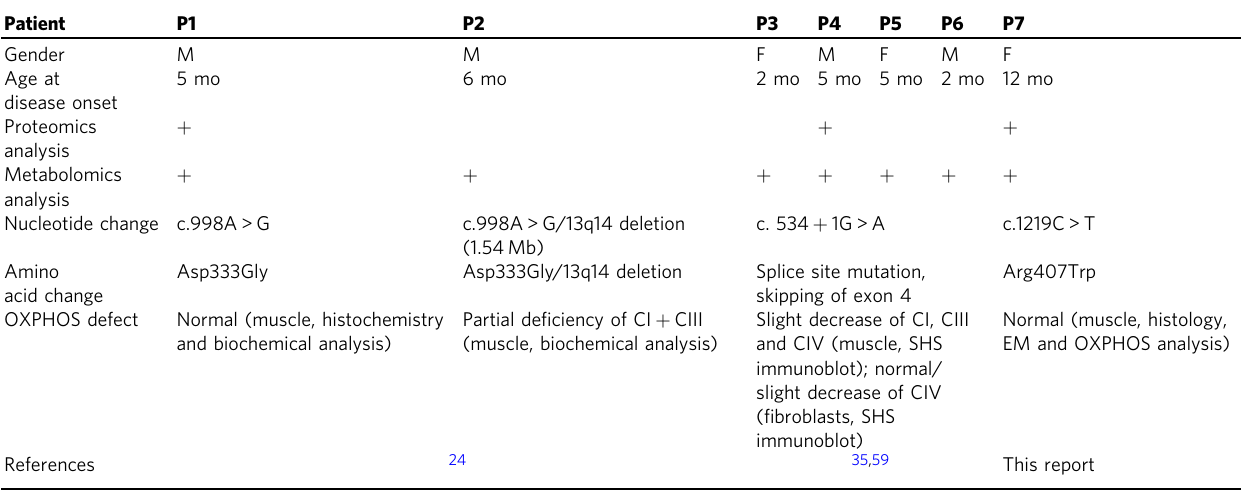
Table 1 Characteristics of SCL patients and respective gene